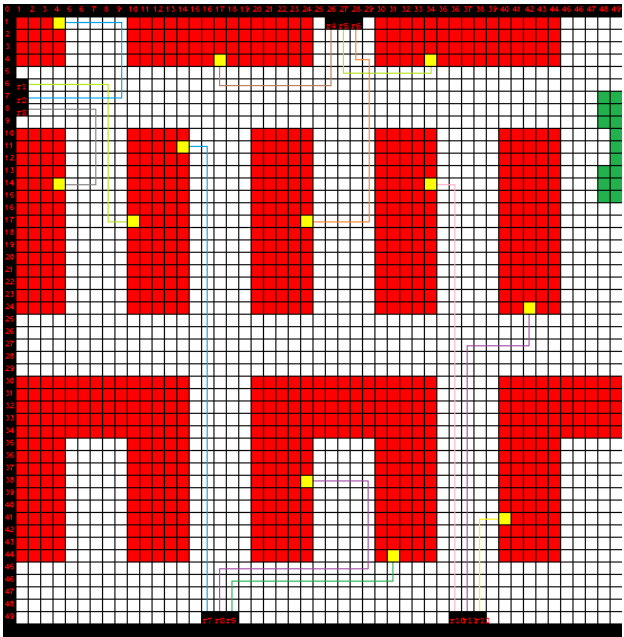
Figure 5. An example synthetic environment generated by our